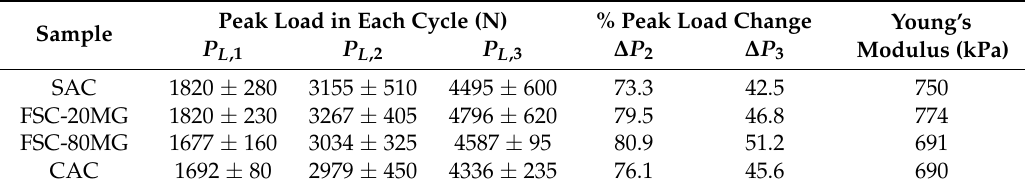
Table 2. Load magnitude from cyclic compression test.